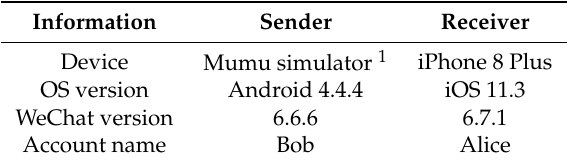
Figure 3. Proposed traffic collection platform for Apple Push Notification service (APNs). Table 1. Information of sender and